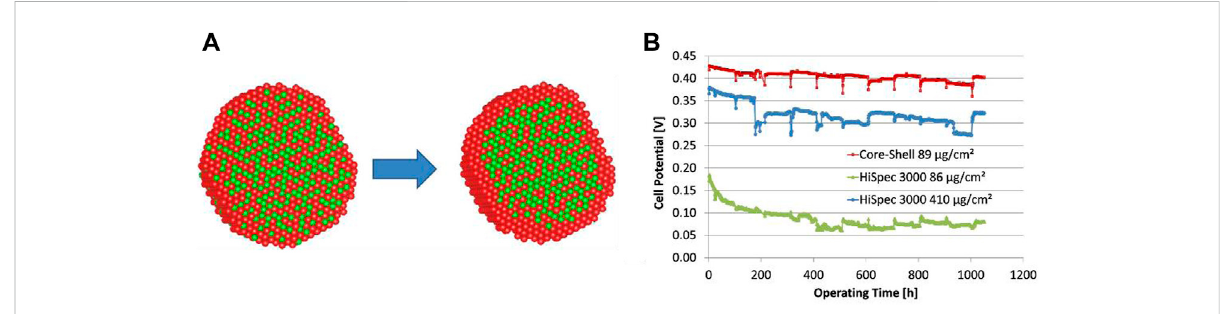
FIGURE 6 (A) Modelofthecore − shellstructurebefore(left)andafter (right)electrochemicaltests; (B) Cellpotential duringlong-term operationat70 ° Cin 0.75 M methanol solution. Reproduced with permission (Glu € sen et al., 2019). Copyright 2019, American Chemical